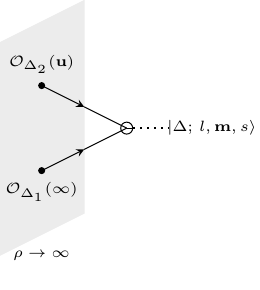
Figure 5 . An OPE